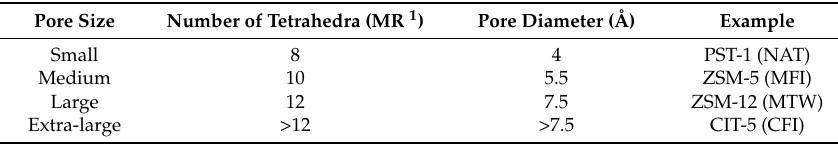
Table 1. Classification of zeolites according to their pore